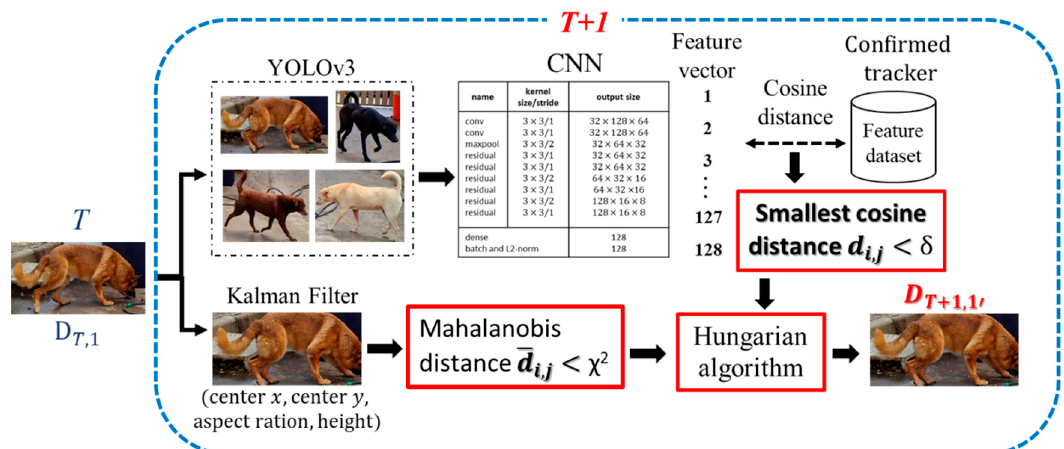
Figure 5. DeepDogSORT dog-tracking model.